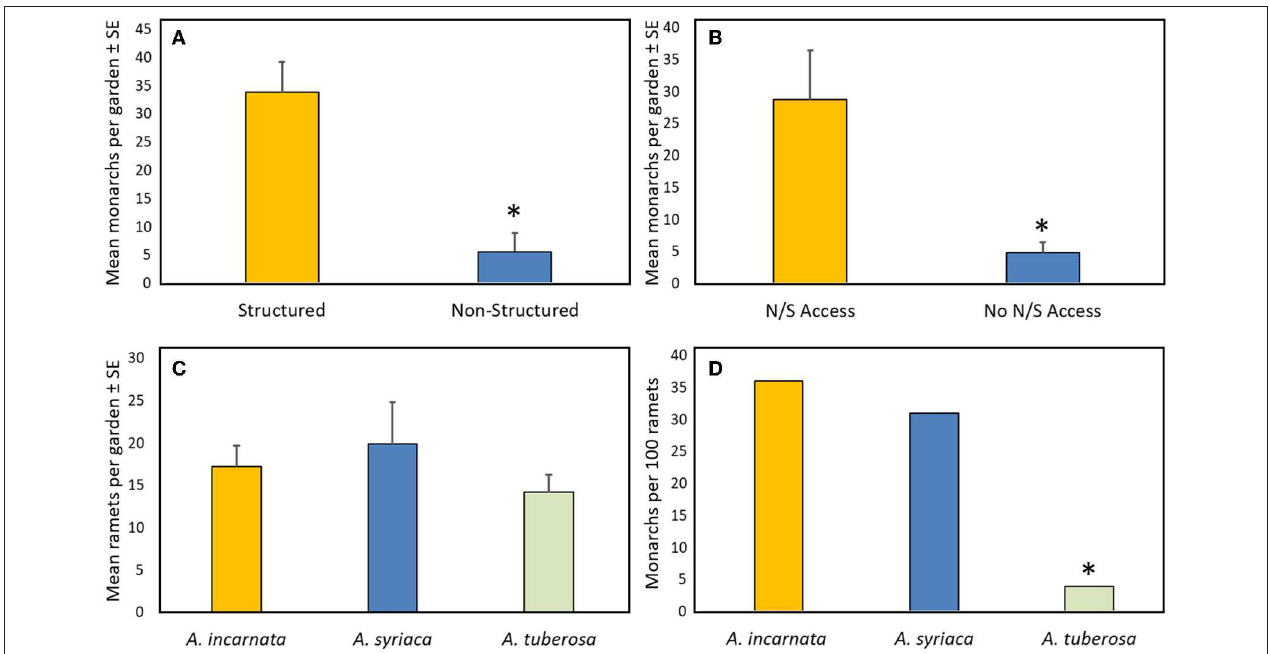
FIGURE 2 | Summary data from season-long survey of citizen-planted Monarch Waystations ( N = 22): (A) Mean total monarchs (eggs and larvae) in structured gardens (milkweeds in uniform array, separated from other plants by ≥ 0.5m) or non-structured gardens (milkweeds closely intermixed with non-host plants); (B) Mean total monarchs (eggs and larvae) in gardens with or without unimpeded north-south access to 100 m: (C) Mean total ramets per garden of the three predominant milkweed species; (D) Mean total monarch eggs and larvae per 100 ramets of each milkweed species. Asterisk denotes significant difference. See text and Table 1 for statistical